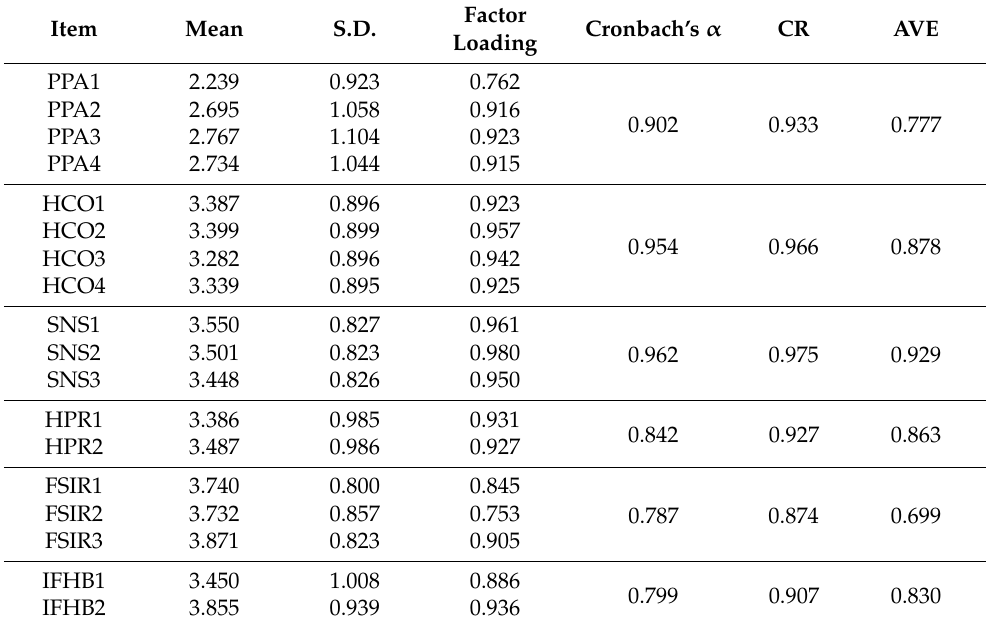
Table 3. Reliability testing and convergent